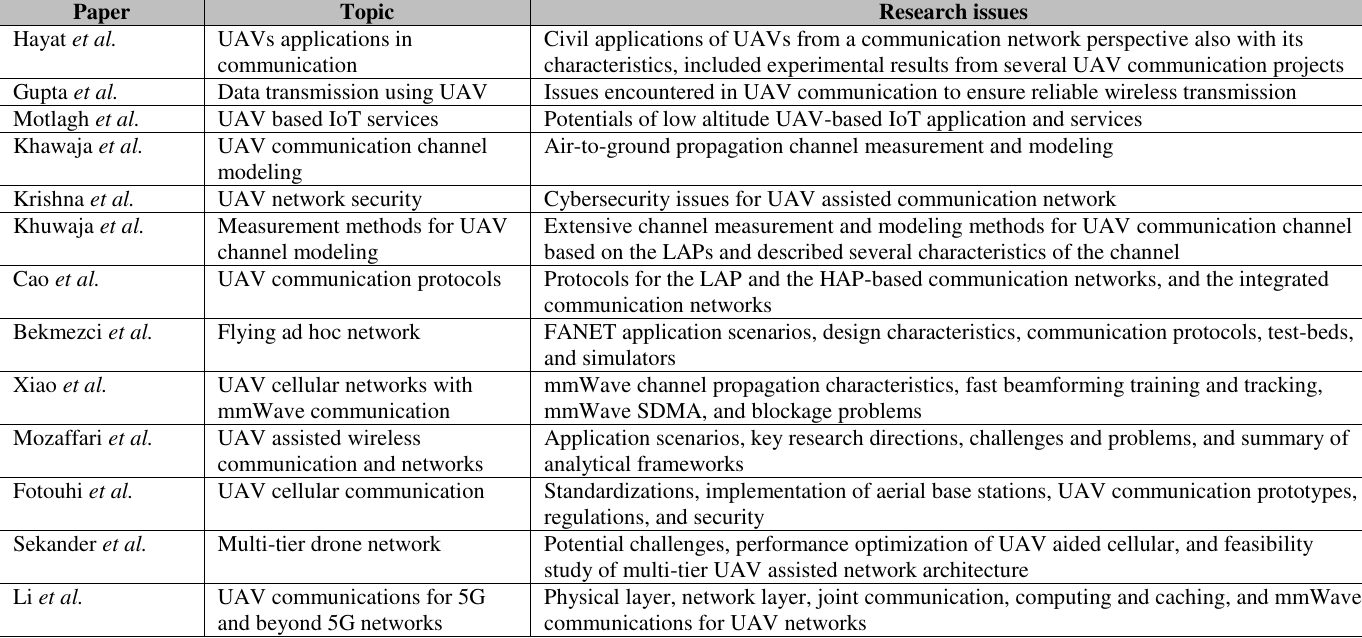
TABLE II: PAPERS ON UAV ASSISTED WIRELESS